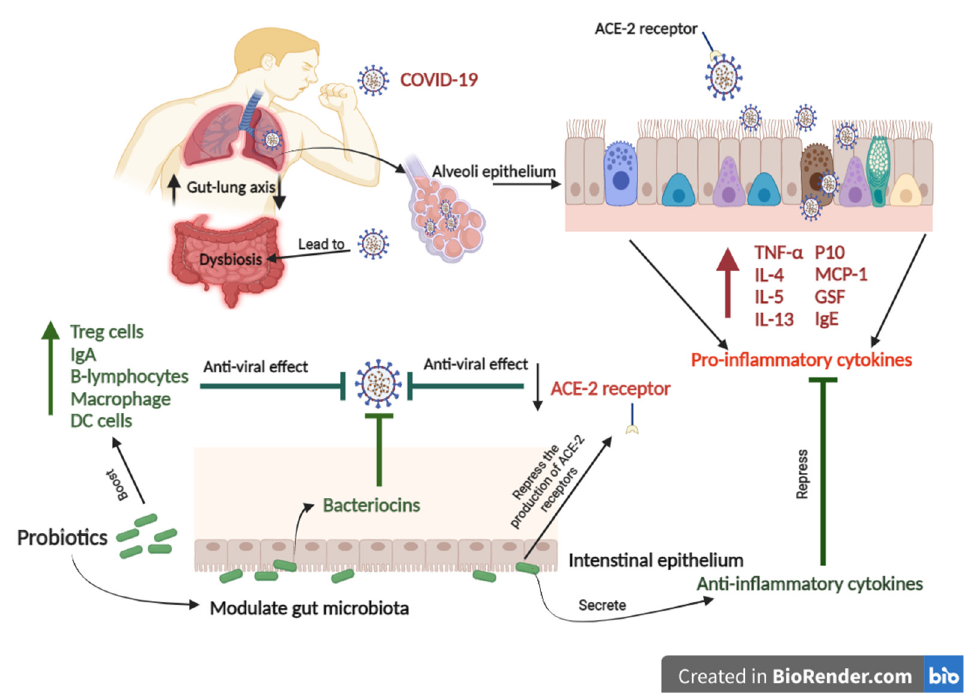
Figure 3. The schematic figure shows the potential mechanism of probiotics to combat COVID-19. COVID-19 binds to the ACE2 receptor that allows the virus to infect the lung alveoli epithelium. COVID-19 leads to gut-lung microbiota dysbiosis associated with increased levels of pro-inflammatory cytokines. In contrast, Probiotics can modulate gut-lung microbiota and repress the production of ACE-2 receptors. Probiotics can also enhance immune responses to prevent COVID-19.